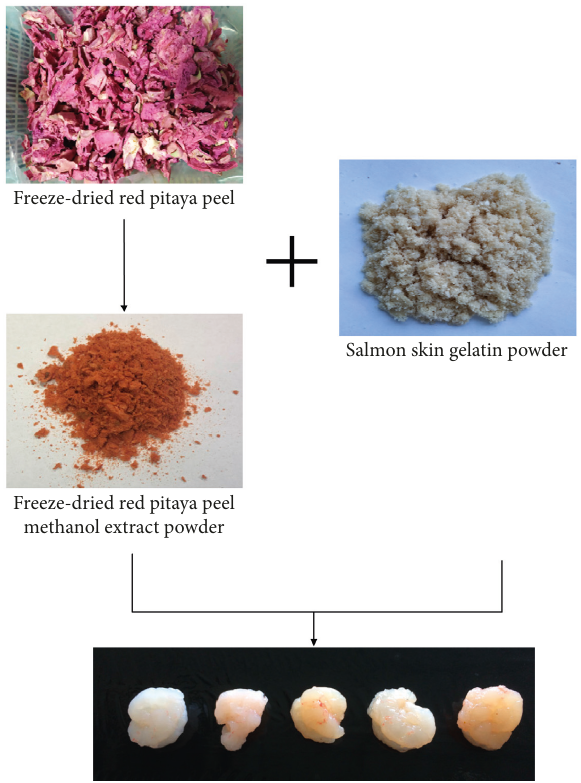
Figure 1: Application of gelatin-based edible coating containing red pitaya peel methanol extract on deshelled crayfish at day